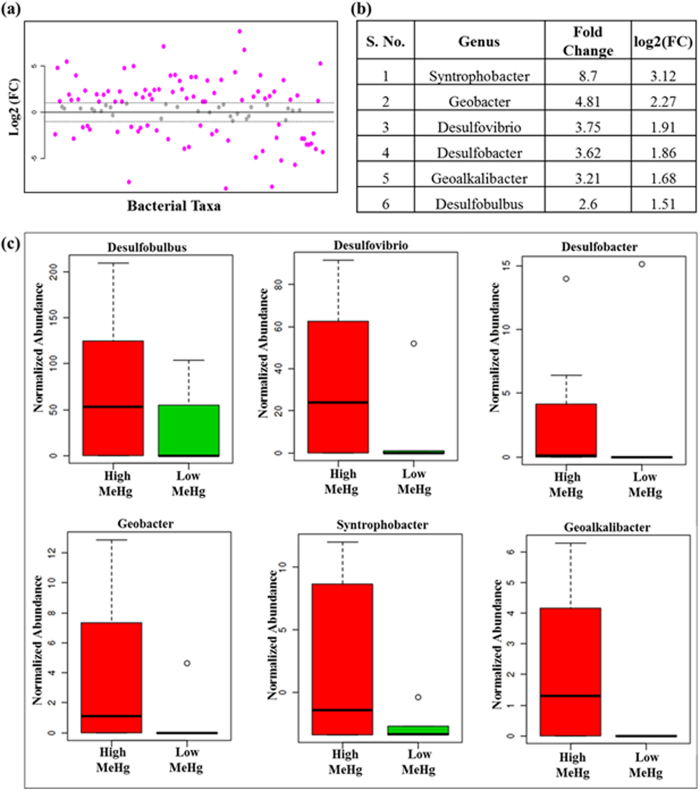
Fold change (FC) analysis between high and low MeHg group means.(a) FC analysis of the bacterial taxa abundance between the high and low MeHg samples (the effect size and direction of the correlation is presented by the FC value and color). (b) The FC value of the significant correlations for important mercury methylating groups. (c) The FC values were calculated as ratio between high and low MeHg group means using normalized data. Shown are box and whisker plots of bacterial taxa abundance change in important Hg methylating bacterial taxa.